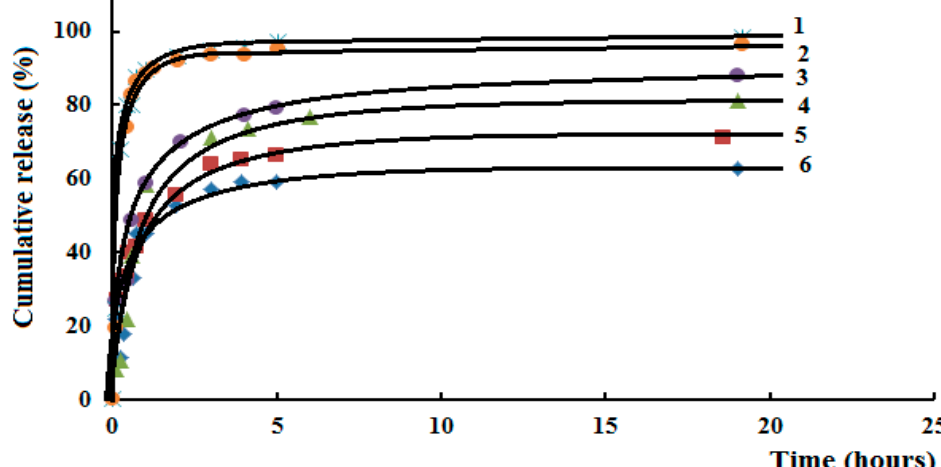
Figure 14. Kinetic curves of cisplatin release from film (1, 2) or hydrogel (3–6) based on chitosan hydrochloride and apple (1, 3, 5) or citrus (2, 4, 6) pectin in saline solution. Concentration of polymers, mg/ml of hydrogel: 6.4 (1, 2, 5, 6) or 3.2 (3, 4). Data are expressed as mean ± SD; n = 3.